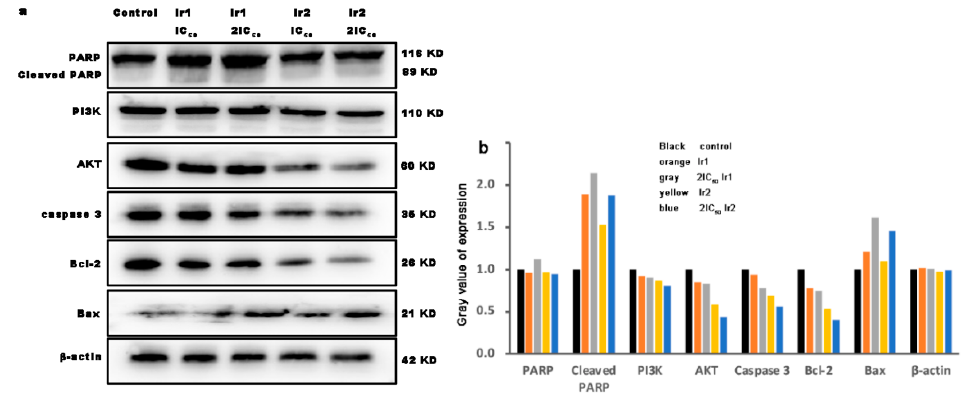
Figure 13. ( a ) Expression of Bcl-2 family proteins after a 24 h exposure of HCT116 cells to IC 50 and 2IC 50 concentration of Ir1 and Ir2 for 24 h. ( b ) The gray values of PARP, caspase 3, PI3K, AKT, Bcl-2 and Bax